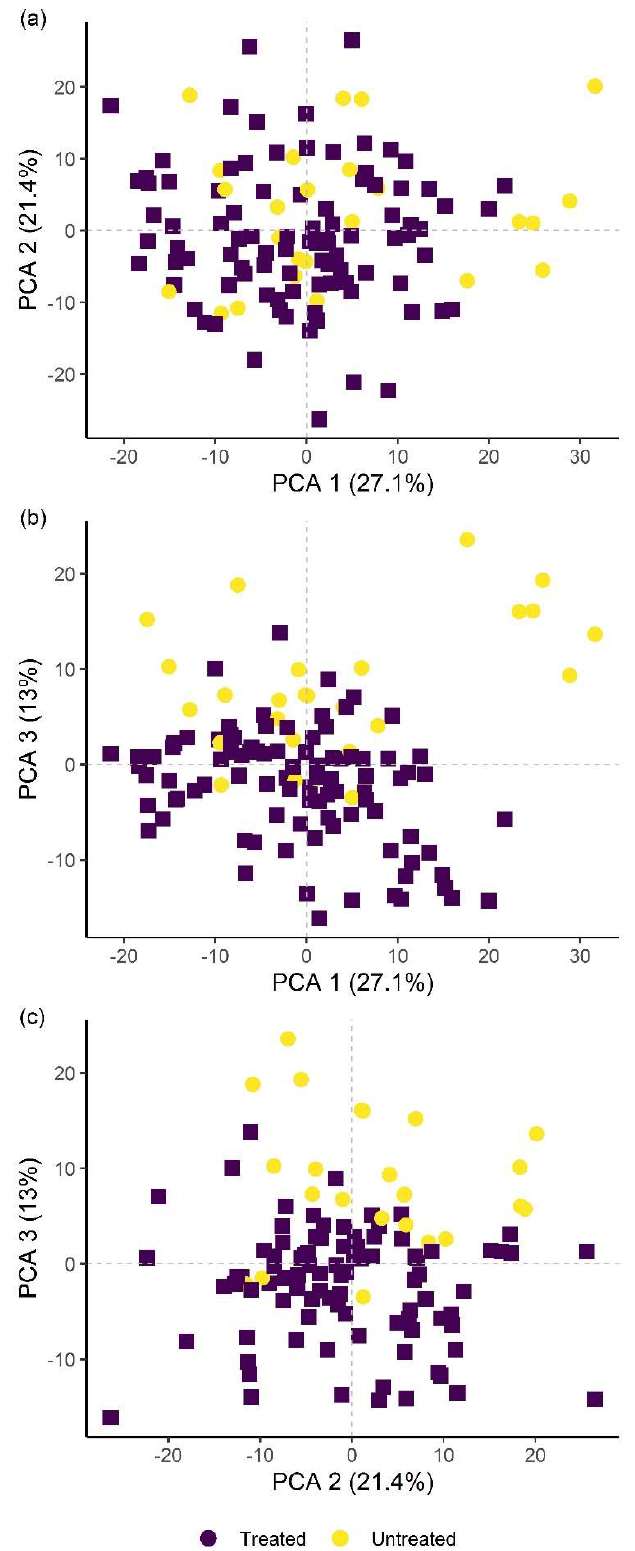
Figure 4. Principal component analysis (PCA) score plots showing the variation in plant groups from the pot experiment with regard to treated (PC, BfL and BfH) or untreated plants (NC). The first three principal components (PCA 1, 2 and 3) explain more than 60% of observed variability and are presented in the combinations ( a ) PCA 1–2; ( b ) PCA 1–3; and ( c ) PCA 2–3. NC—negative control; PC—positive control (nematicide); BfL—low B. firmus inoculum; BfH—high B. firmus inoculum.